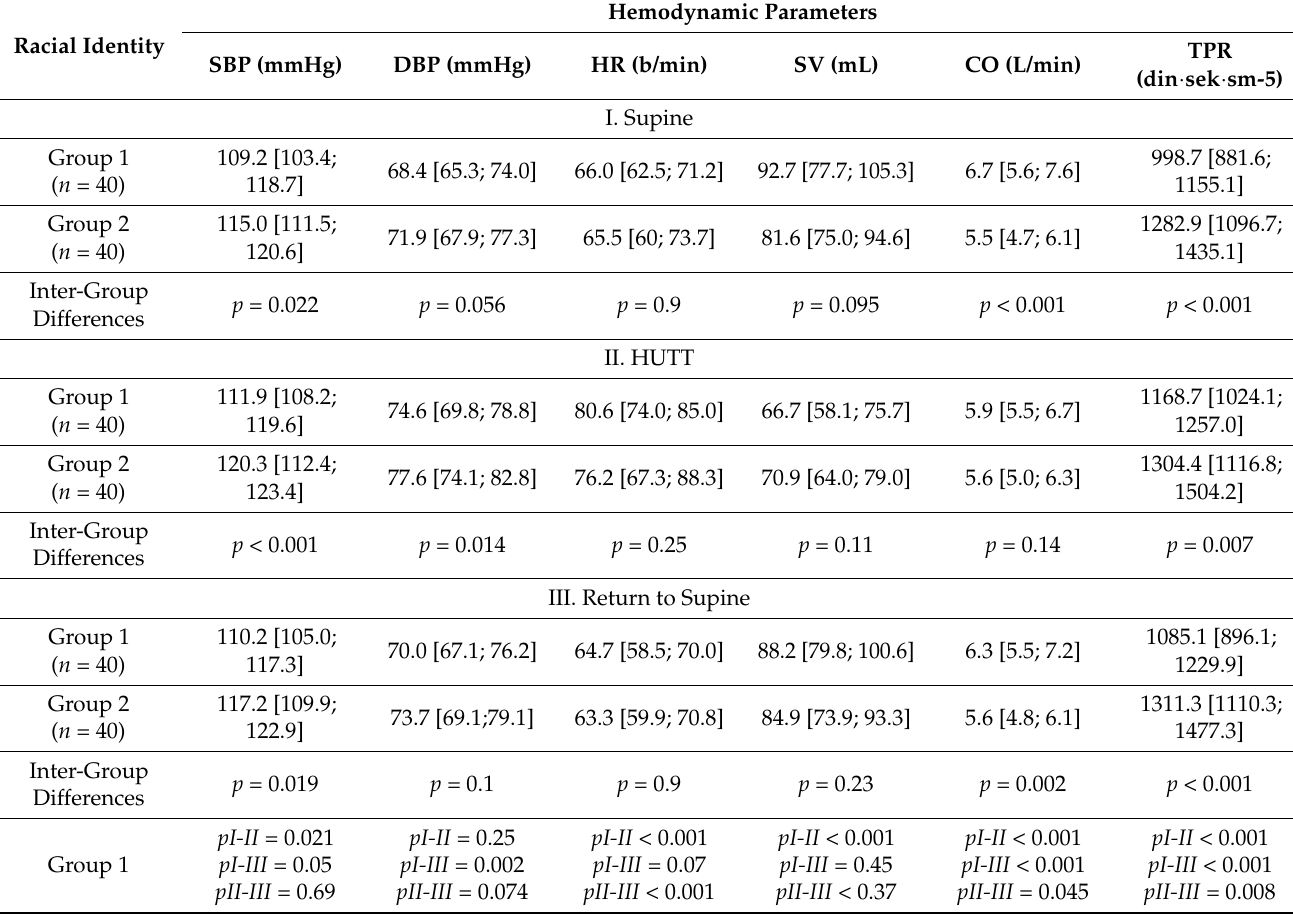
Table 2. The inter-group analysis of selected hemodynamic parameters at different stages of the